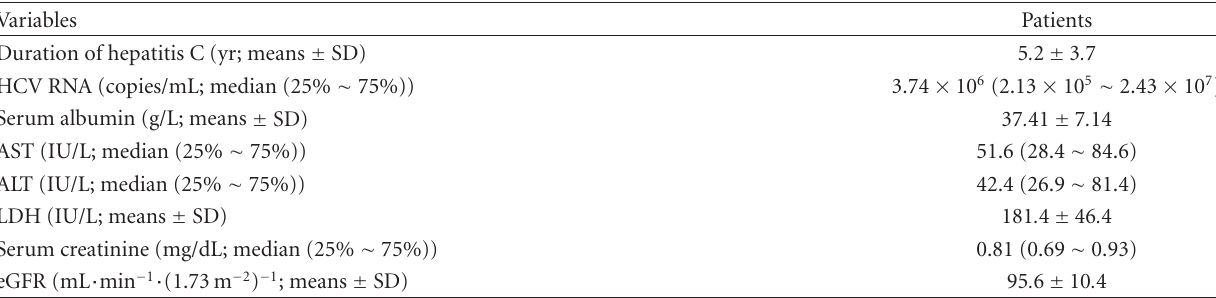
Table 2: Clinical characteristics of patients group.